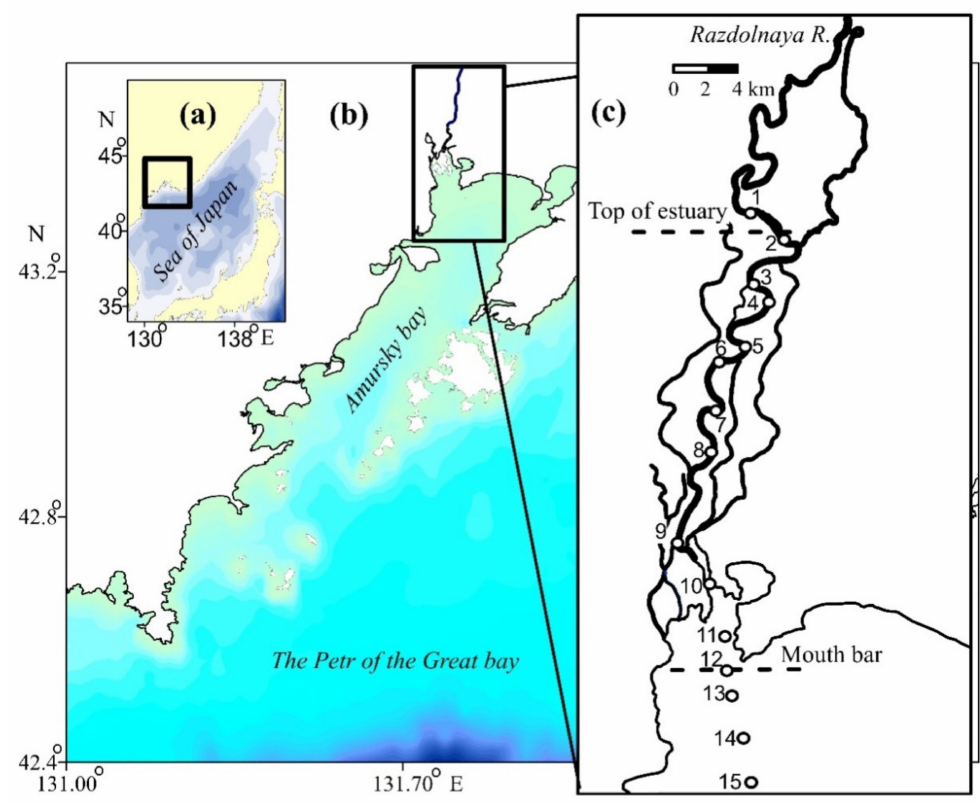
Figure 1. Map of study area: ( a ) Sea of Japan, ( b ) The Peter the Great Bay, ( c ) position of monitoring stations at Razdolnaya R.